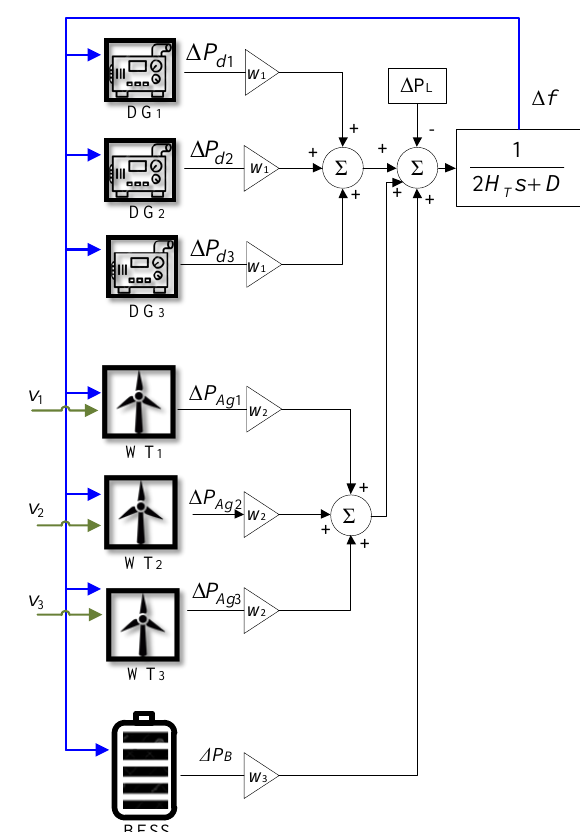
Figure 2. Load frequency control scheme of the test system.